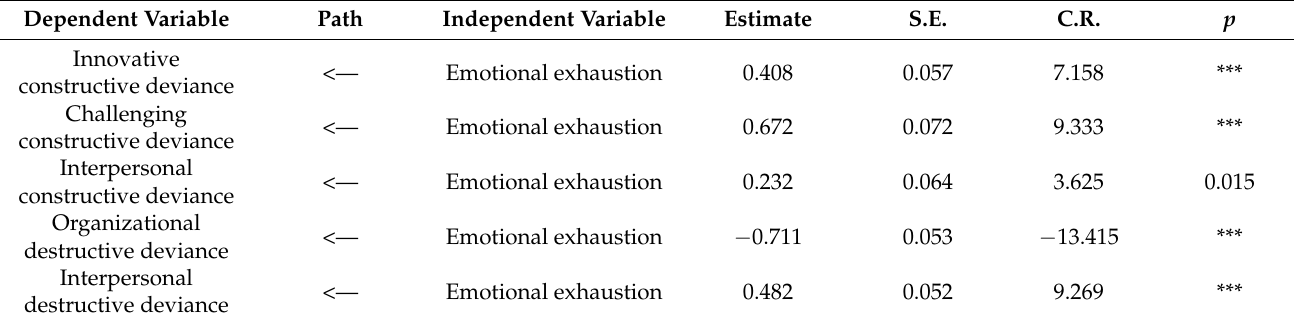
Table 7. Path test of emotional exhaustion to deviant